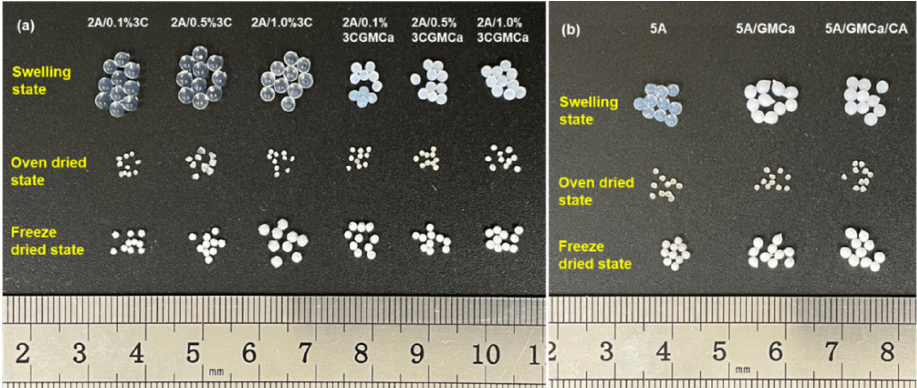
Figure 6. Photographs of the beads in different states: (top) swelling state, (middle) oven-dried state, and (bottom) freeze-dried state; ( a ) alginate-chitosan (2A/x%3C, x = 0.1, 0.5, 1.0) and GM-loaded alginate-chitosan (2A/x%3CGMCa, x = 0.1, 0.5, 1.0) beads, and ( b ) alginate (5A), GM-loaded alginate (5A/GMCa), and GM-loaded alginate crosslinked with citric acid (5A/GMCa/CA) beads.